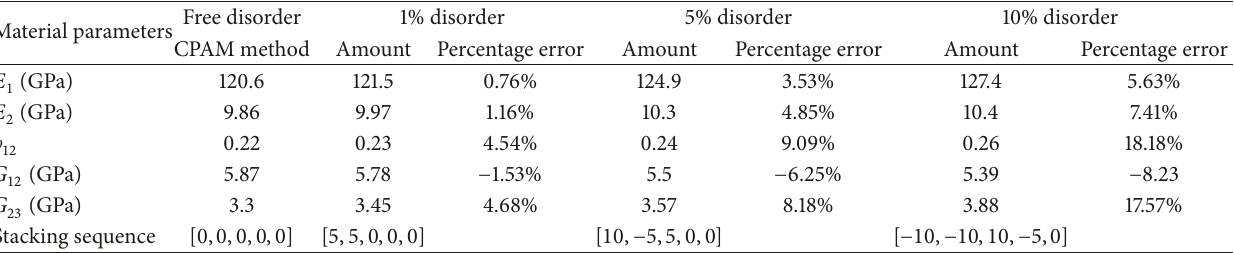
Table 13: Elastic constants determined for specimen D1 for different levels of disorder.